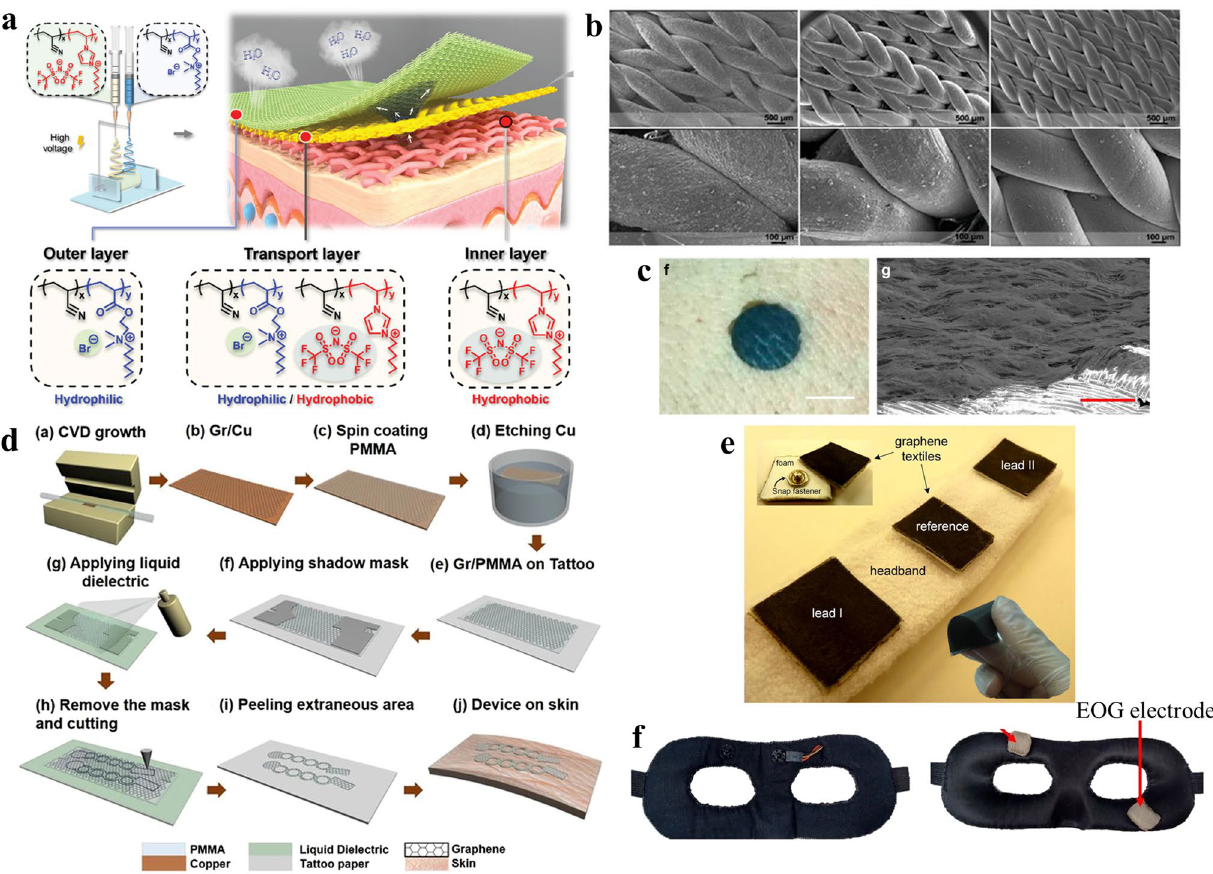
Fig. 1 a Schematic illustration of the dual‑gradient poly (ionic liquid) nanofiber‑based e‑skin electrode. Reproduced with permission from Ref. [29]. Copyright 2021 Wiley. b SEM images of textile e‑skin made from different conductive elastomeric fibers. Reproduced with permission from Ref. [30]. Copyright 2022 Wiley. c Photograph and SEM images of the substrate‑free e‑skin on the human skin. The scale bars represent 1 cm and 200 μm, respectively. Reproduced with permission from Ref. [31]. Copyright 2020 American Chemical Society. d Fabrication process of the imperceptible graphene‑based EOG e‑skin electrode. Reproduced with permission from Ref. [36]. Copyright 2018 Springer Nature. e EOG headband with graphene textile e‑skin electrodes. Reproduced with permission from Ref. [19]. Copyright 2019 IOPscience. f EOG e‑skin integrated with an eye mask. Reproduced with permission from Ref. [38]. Copyright 2021